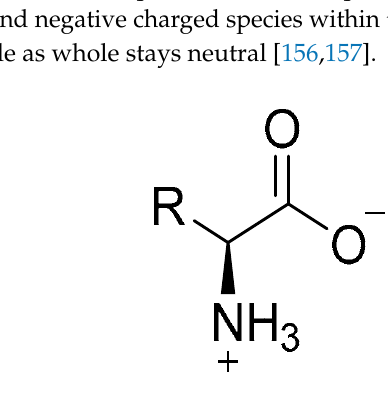
Table 2. Enlists all 20 proteogenic amino acids. It highlights acidic, basic and neutral amino acids with their pKa and pI values. Data collected from Haynes,William M., 2014 [159].